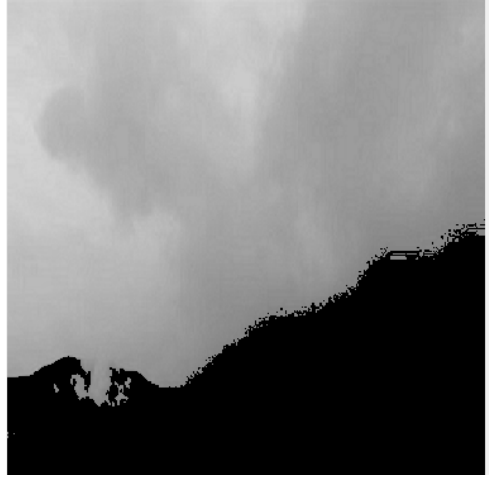
Figure 4. The sky segmentation